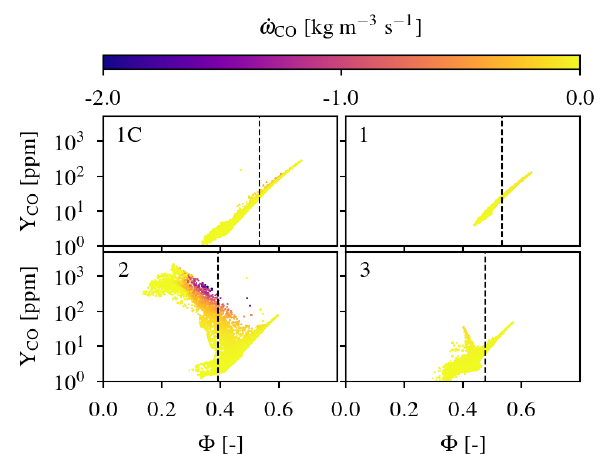
Figure 5. Carbon monoxide mass fractions over Φ in dependency of the CO reaction rate at the combustor exit cross-section for cases 1C, 1, 2 and 3. The vertical dashed line marks the nominal global equivalence ratio.